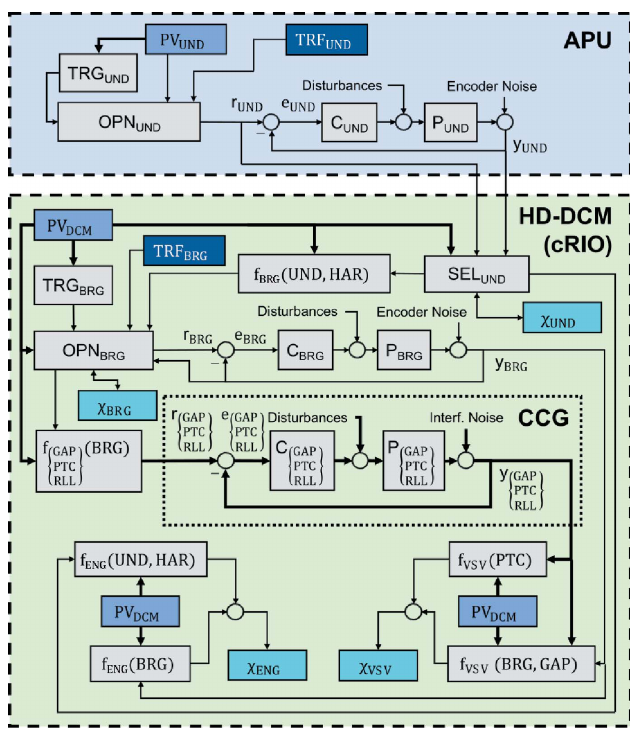
Figure 6 Simplified control implementation diagram for the integration of the HD- DCM running on NI’s cRIO, with four control loops for the Bragg angle (BRG) and crystal cage (CCG, with GAP, PTC and RLL) position control, and an APU source running on a third-party controller, with one control loop for the phase. Reference r and metrology y signals are represented, together with controllers C , plants P , and functions f for coordinated motion. As detailed in the text, motion setpoint updating depends on structures for input selection (SEL) and operation modes (OPN), including trajectory generation on demand (TRG), stored trajectory files (TRF) and motion estimators ( (cid:9) UND and (cid:9) BRG ). Complementary real-time performance estimators can be computed for energy tuning ( (cid:9) ENG ) and virtual source vertical position ( (cid:9) VSV ). Integration with EPICS is represented by the process variables (PVs). Colors are given to differentiate the APU from the HD-DCM domains, and the control blocks from data blocks (related trajectories or PVs), and from the